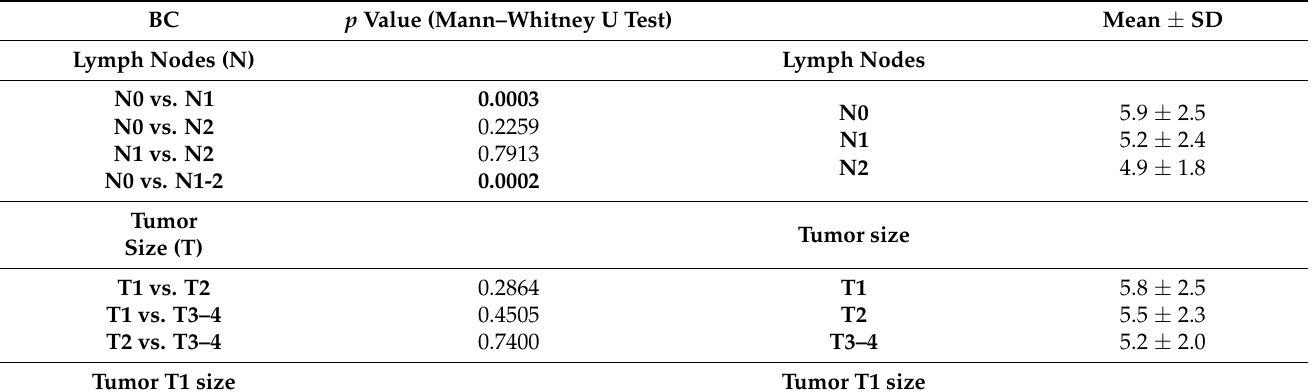
Table 2. Association of irisin expression level with clinicopathological characteristics according to the World Health Organization criteria [28] in patients with BC; significance in